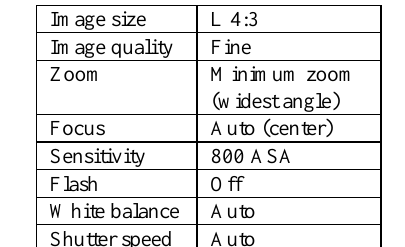
Table 2. Settings of the Fujifilm Finepix Real 3D W3